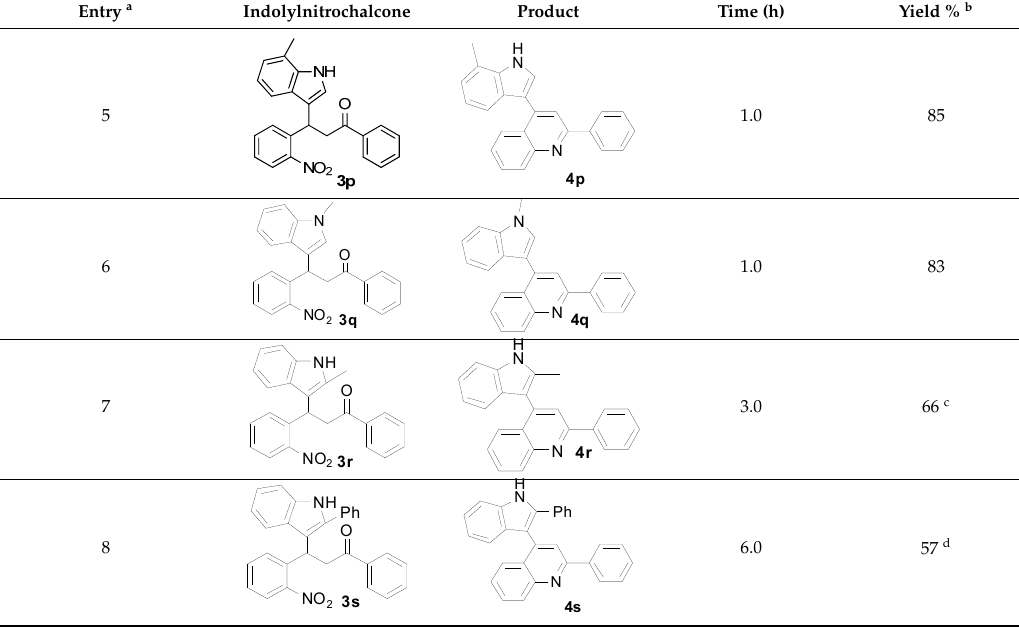
Molecules 2015 , 20 , page–page